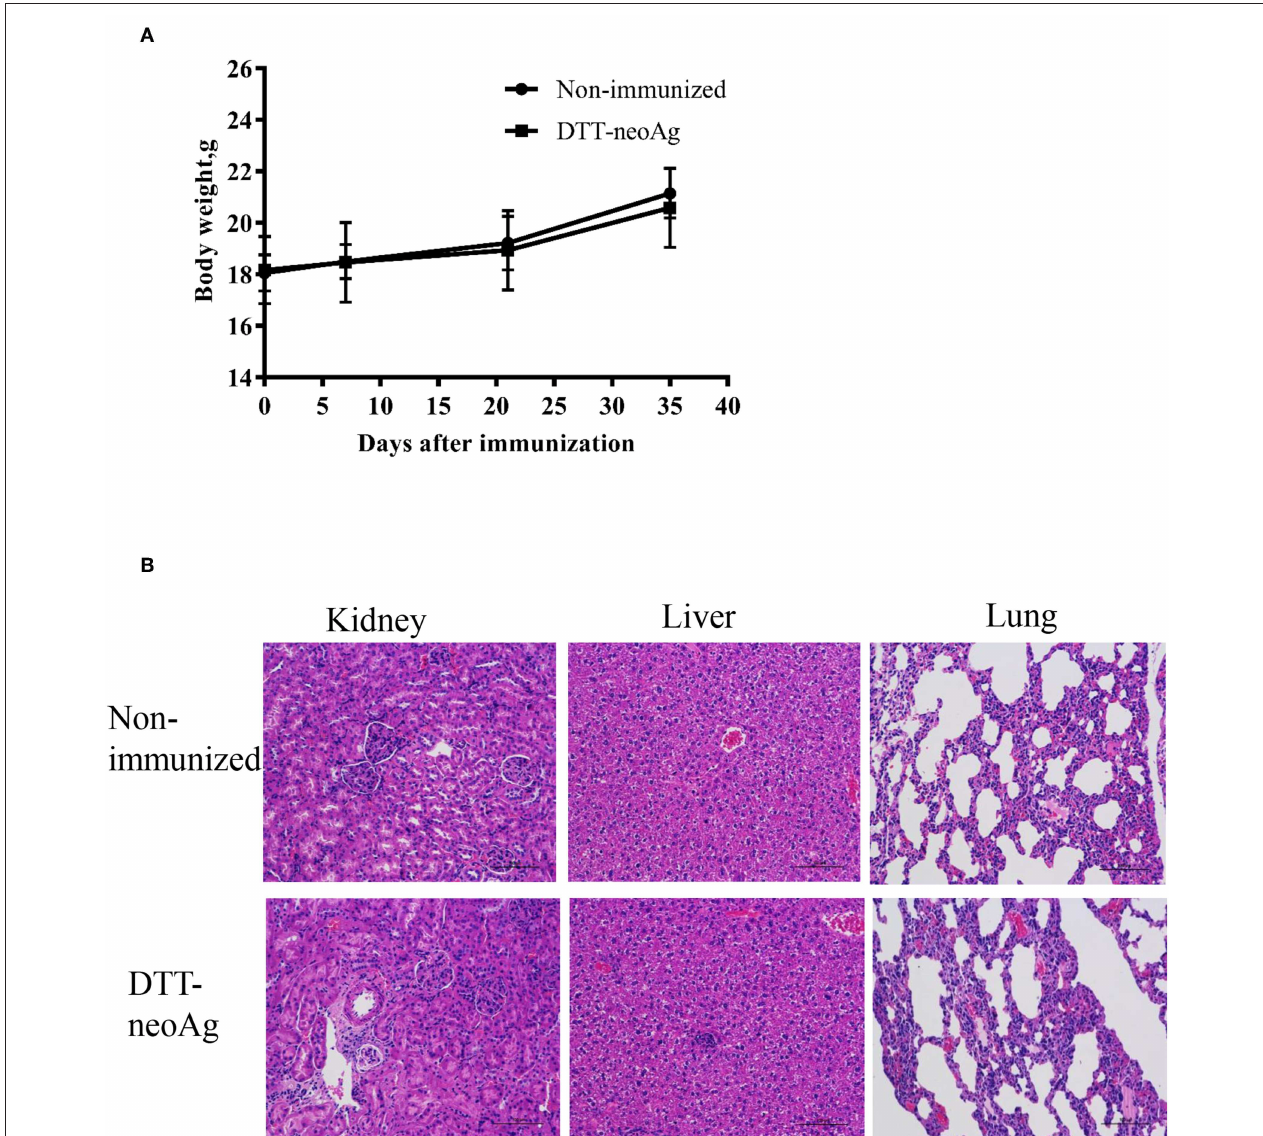
FIGURE 8 | Toxicity evaluation of DTT-neoAg. (A) The body weight of the two groups were measured at 7 days after each immunization. (B) Morphology evaluation by H&E. Two hundred and ten days after the third immunization, the kidneys, livers, and lungs of DTT-neoAg-immunized mice were collected and analyzed by